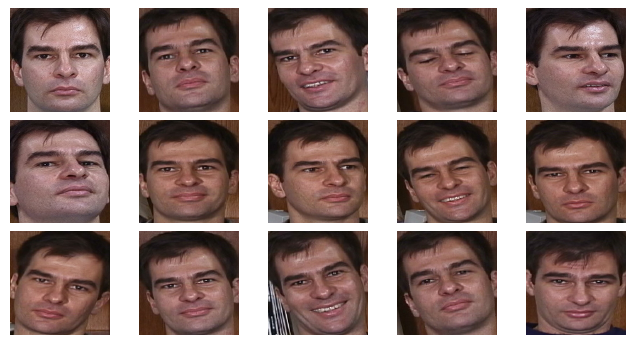
Figure 5. Fifteen pictures of one individual in the